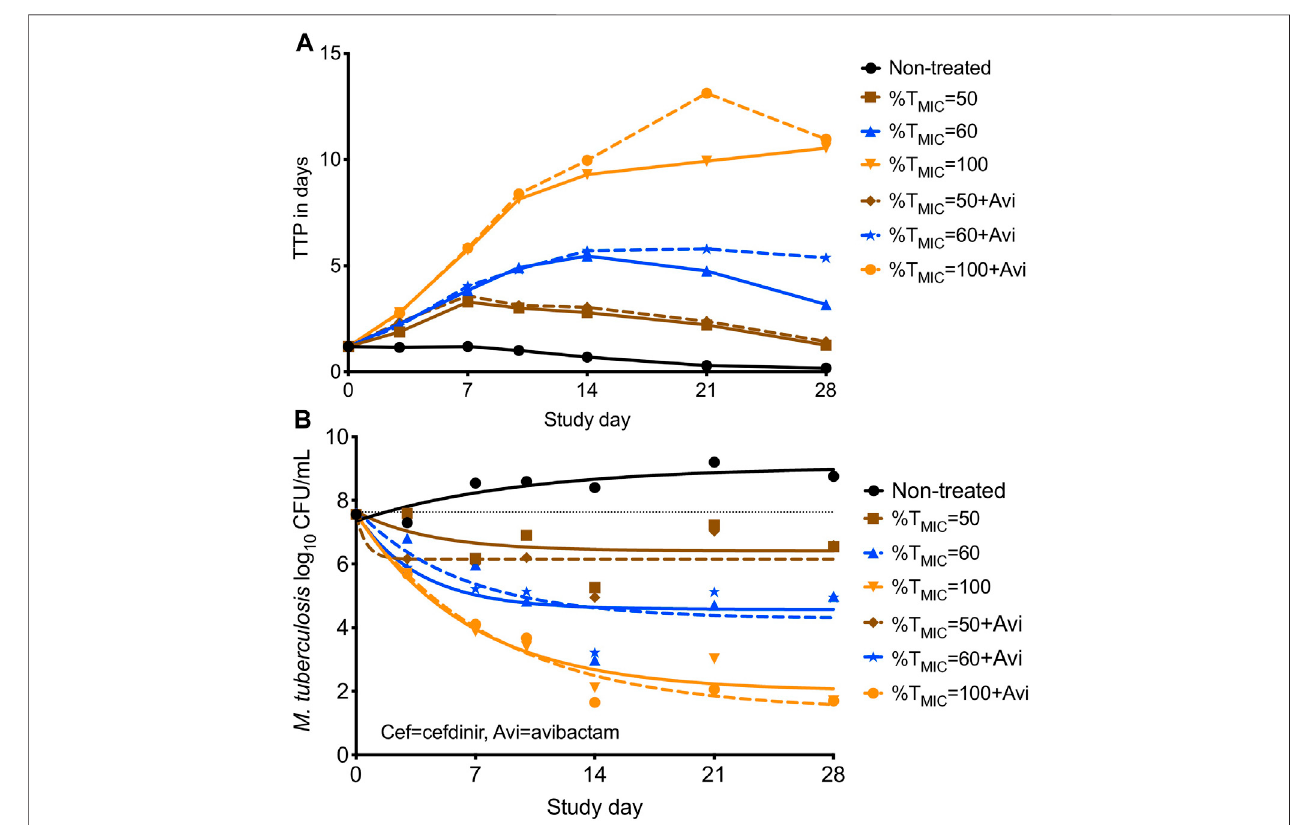
FIGURE 3 | Cefdinir ’ s bactericidal activity against M. tuberculosis with or without avibactam in the hollow fi ber system. (A) Higher the TTP, lower the bacterial burden.TheTTPintheHFS-TBtreatedwithdifferentcefdinirexposures[%T MIC ]werevirtuallysimilar,irrespectiveofthepresenceofabsenceofavibactam, (B) TheCFU/ mL results were similar to that of the TTP. Combination of avibactam did not result in improved bacterial kill. *Avi, avibactam.